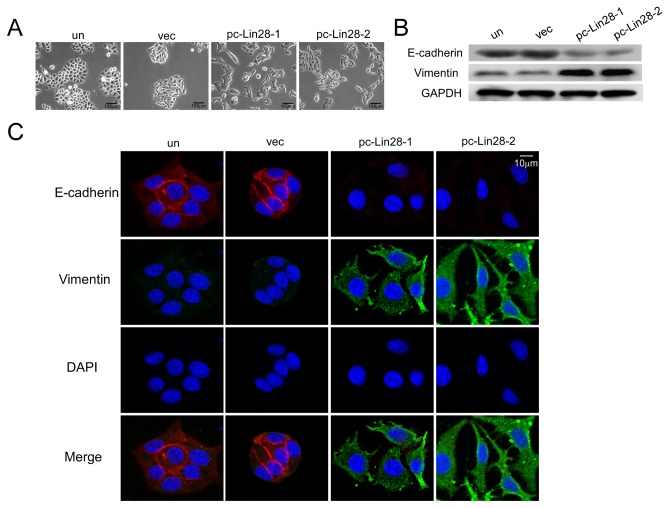
Lin28 promotes epithelial-to-mesenchymal transition in MCF-7 cells.A. Ectopic expression of Lin28 in pc-Lin28-1 and pc-Lin28-2 MCF-7 clones induced MCF-7 cells to adopt mesenchymal shapes. B and C. Western blotting (B) and Immunoﬂuorescence staining (C) illustrated reduced expression of E-cadherin and increased expression of vimentin in pc-Lin28-1 and pc-Lin28-2 cells. E-cadherin: red, vimentin: green, cell nuclei: blue. Bar, 10 μm.